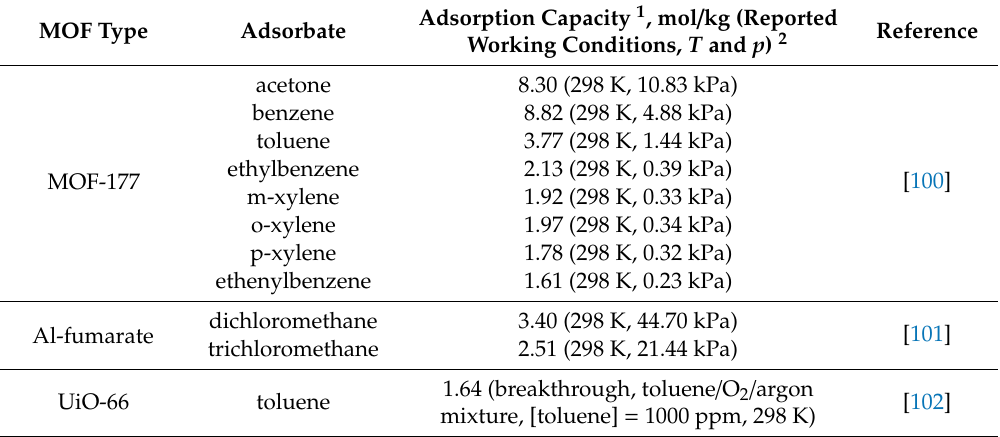
Table 4. MOFs potentially suitable for the adsorption of volatile organic compounds